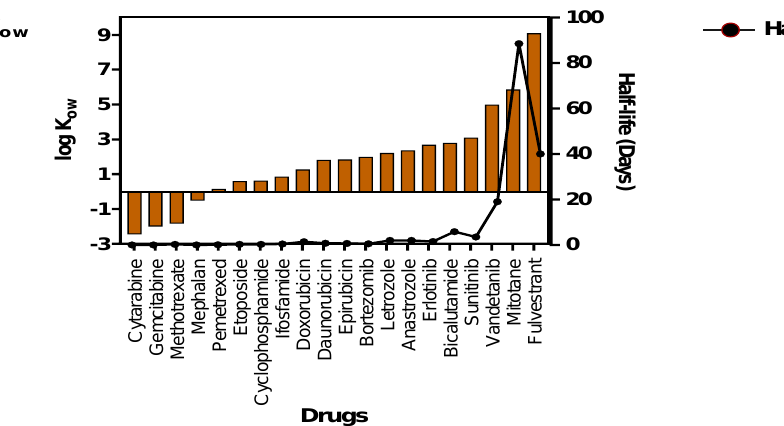
Figure 2. Plot indicating relationship between hydrophobicity and half-life of common ANP drugs. Drugs list obtained from NIOSH List of Antineoplastic and Other Hazardous Drugs in Healthcare Settings, 2016 (https: // www.cdc.gov / niosh / docs / 2016$-$161 / pdfs / 2016-161.pdf?id = 10.26616 / NIOSHPUB2016161). K ow and half-life values were obtained from PubChem (https: // pubchem.ncbi.nlm.nih.gov / ) and DrugBank (https: // www.drugbank.ca /